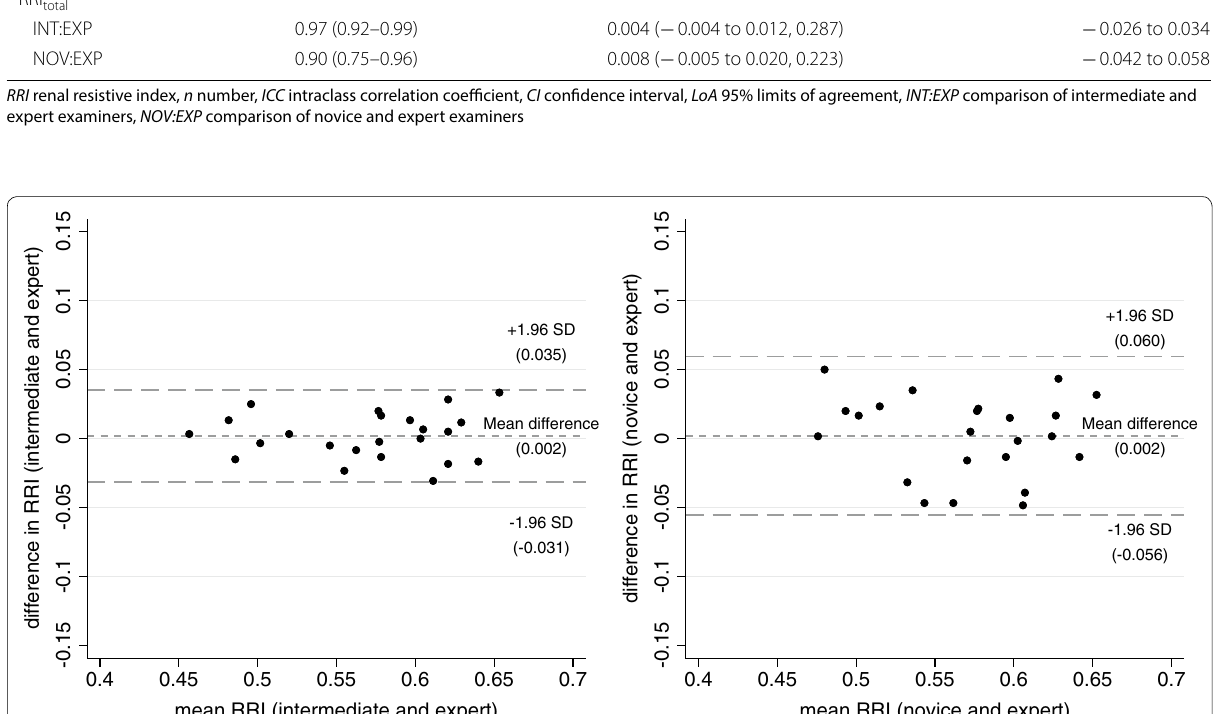
Fig. 1 Bland Altman plots showing the comparison between renal resistive index (RRI) measurements by the intermediate and expert examiner and the novice and expert examiner. Bias is indicated by the mean difference between respective non‑expert and the expert, and precision is indicated by the 95% limits of agreement represented by the mean 1.96 standard deviations ±